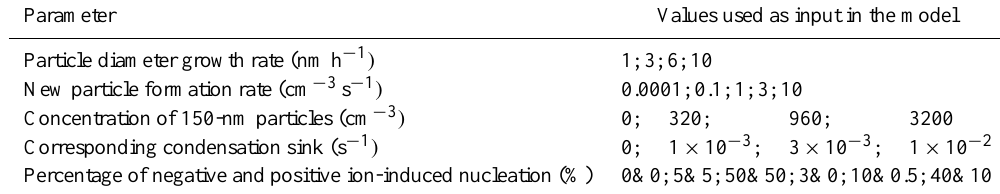
Table 2. Summary of the growth rate scenarios described in Sects. 3.2.1–3.2.5. Scenario GR of neutral particles GR of charged